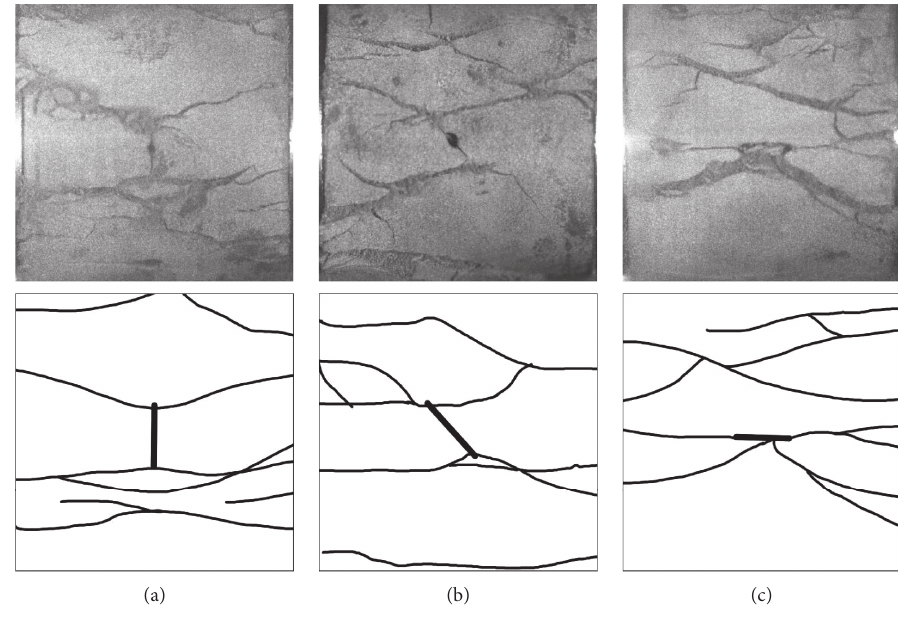
Figure 10: Final failure mode of specimens. (a) 0 ° . (b) 45 ° . (c) 90 °